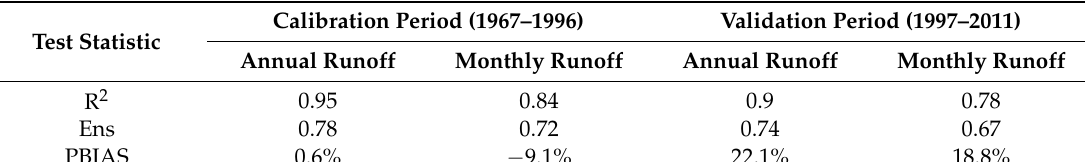
Table 2. Performance statistics in the calibration and validation periods.